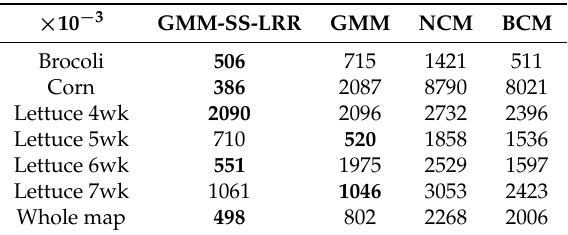
Table 5. Abundance errors for Sainas-A dataset.